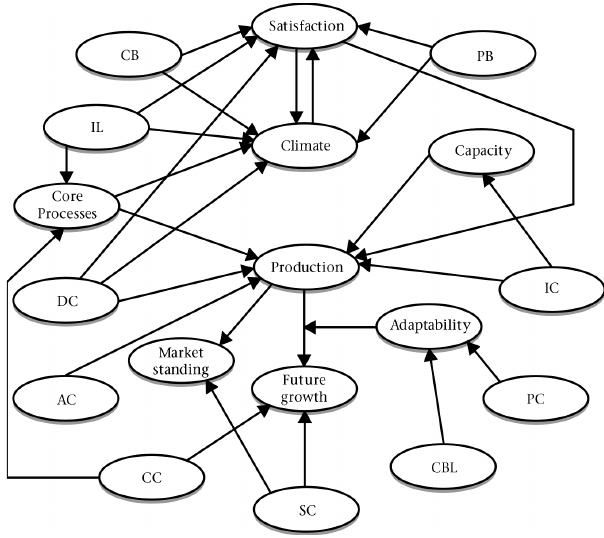
Figure 1: Hypothesized linkages between HPLC and